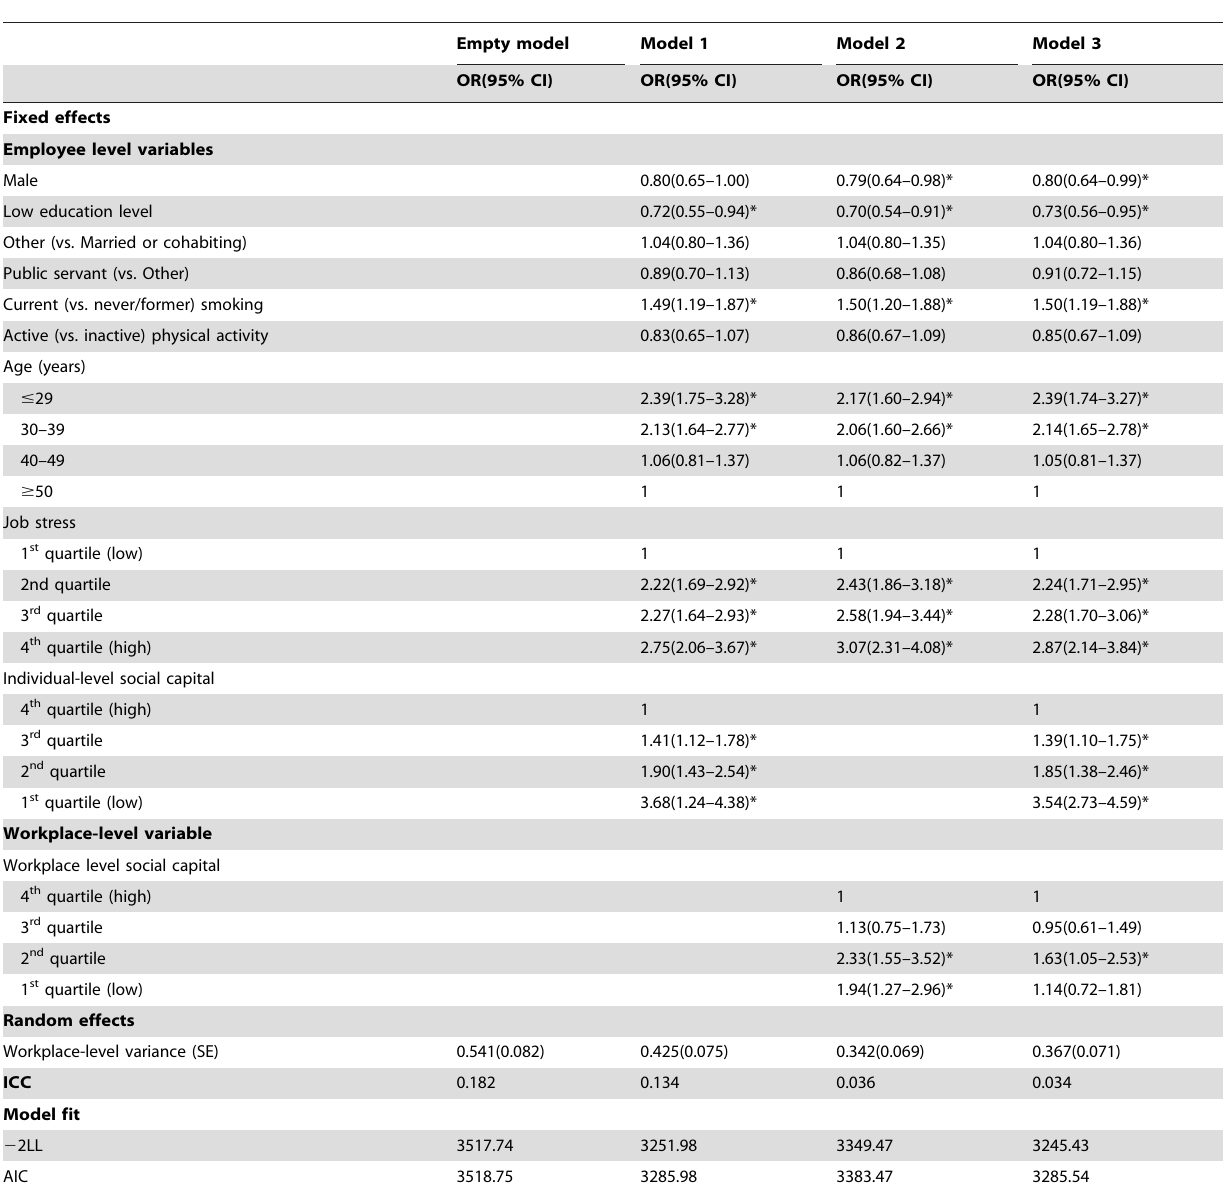
Table 2. Model fit, odds ratios, and 95% confidence intervals for multilevel regression models of workplace social capital and mental